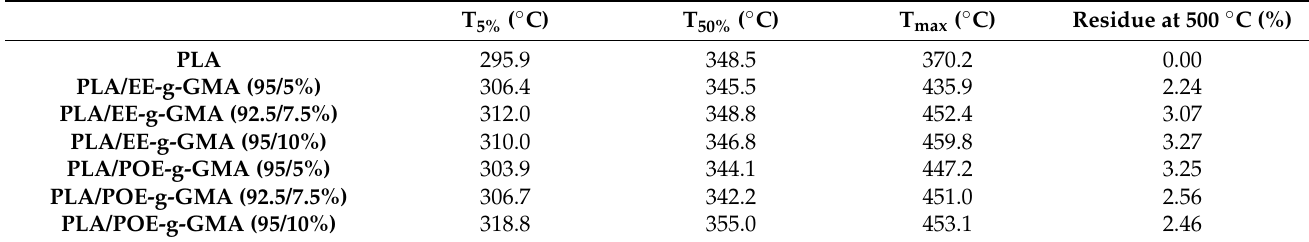
Table 3. Degradation data obtained from TG of the compositions.